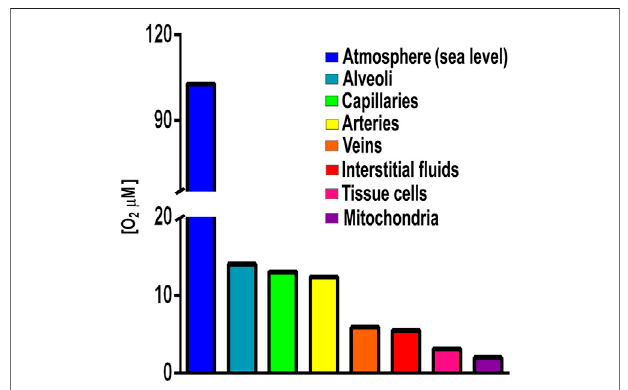
FIGURE 1 | Oxygen concentrations in different compartments in an oxyregulator organism. Atmospheric [O 2 ] 1,028 μ M, lung alveoli [O 2 ] 143 μ M; capillaries [O 2 ] 130 mM; arteries [O 2 ] 123 μ M; interstitial fl uids [O 2 ] 55 μ M; tissue cells